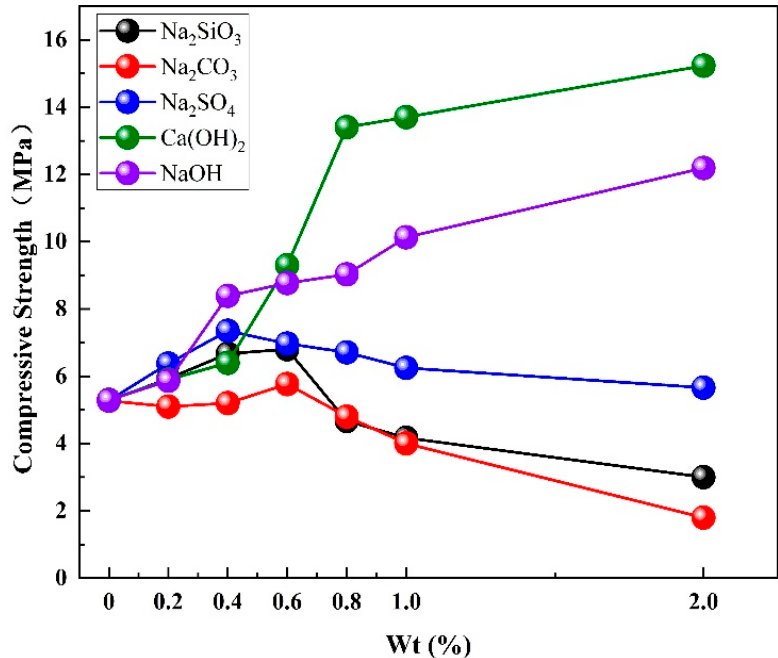
Figure 3. Compressive strength of solidified sludge samples with different additives.